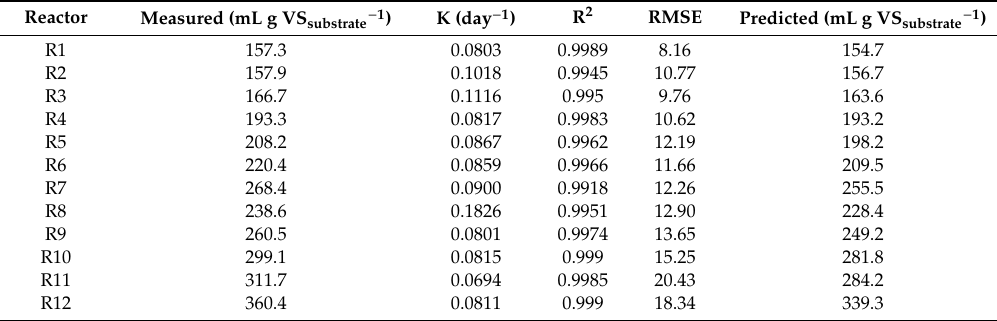
Table 3. Results of the kinetic study using the first order and cone